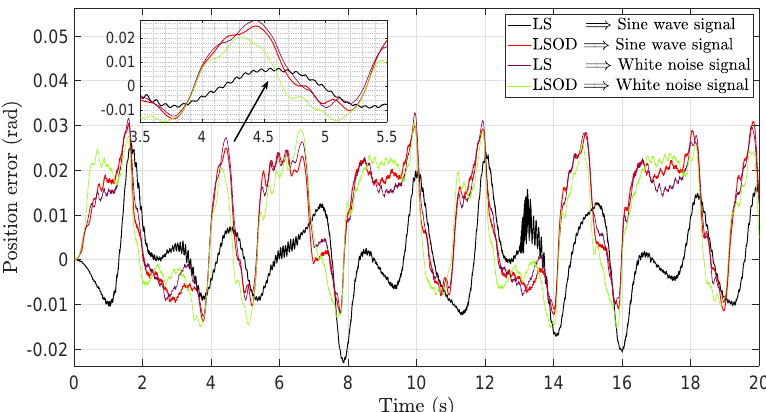
Figure 12. Position errors produced by control law (62) with the parameter estimate β ∗